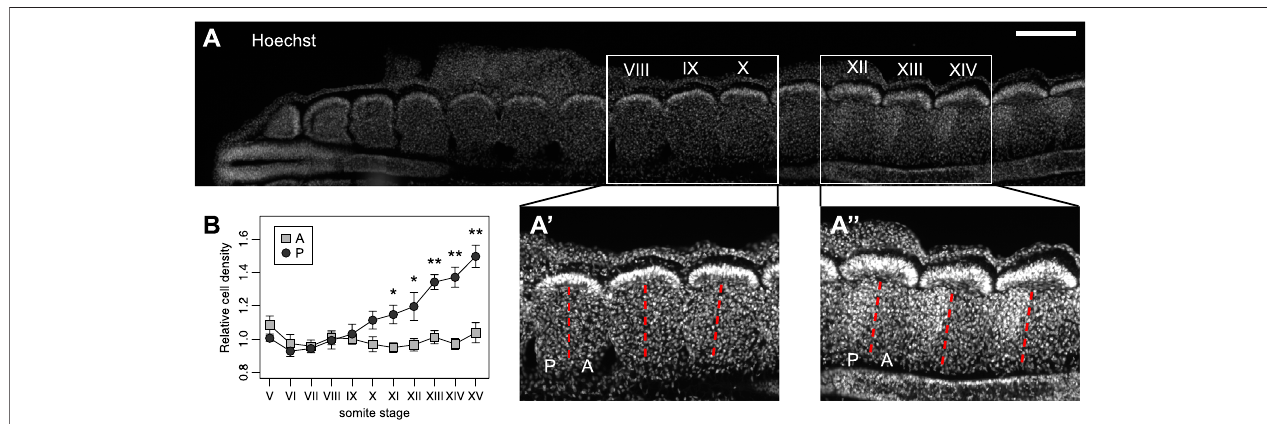
FIGURE 3 | Intrasegmental differences in tissue stiffness arise before motor axon outgrowth and before differential cell density. (A) Immunohistochemistry on a frontalsectionofachickembryoshowingthegraduallyhigherdensityofcellnuclei(Hoechst,blue)alongtheantero-posterioraxis.Scalebar:200 μ m.(A ′ )and(A ″ )zoom of somite stages VIII-X and XII-XIV, respectively. (B) Quanti fi cation of cell densities in anterior and posterior halves of somite stages V – XV. Each point represents the average of cell densities relative to the anterior halves for each embryo. Error bars represent standard error of the mean. Wilcoxon rank sum test, * p < 0.05, ** p < 0.01. N = 5